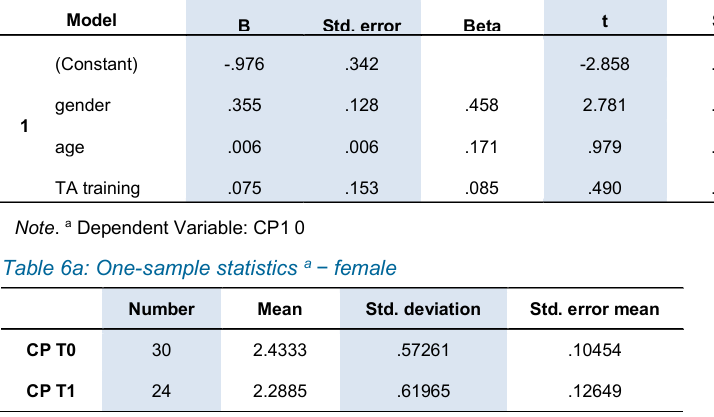
Table 6b: One-sample test a − female